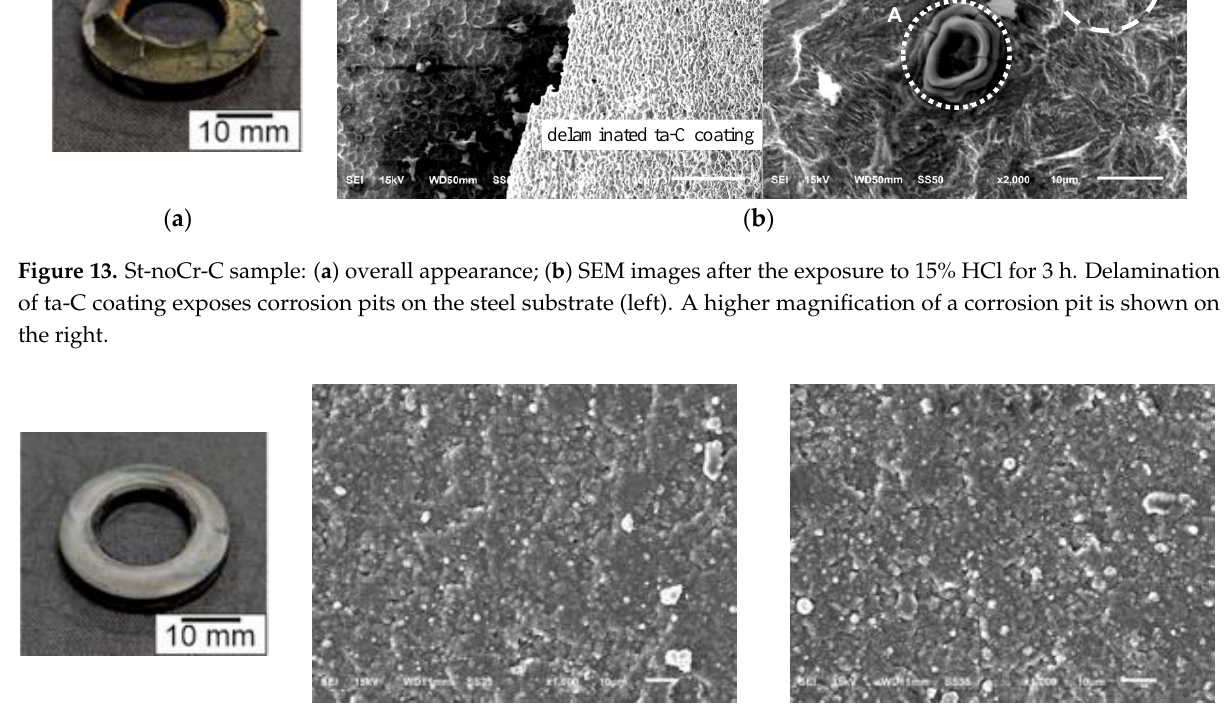
Figure 13. St-noCr-C sample: ( a ) overall appearance; ( b ) SEM images after the exposure to 15% HCl for 3 h. Delamination of ta-C coating exposes corrosion pits on the steel substrate (left). A higher magnification of a corrosion pit is shown on the right.